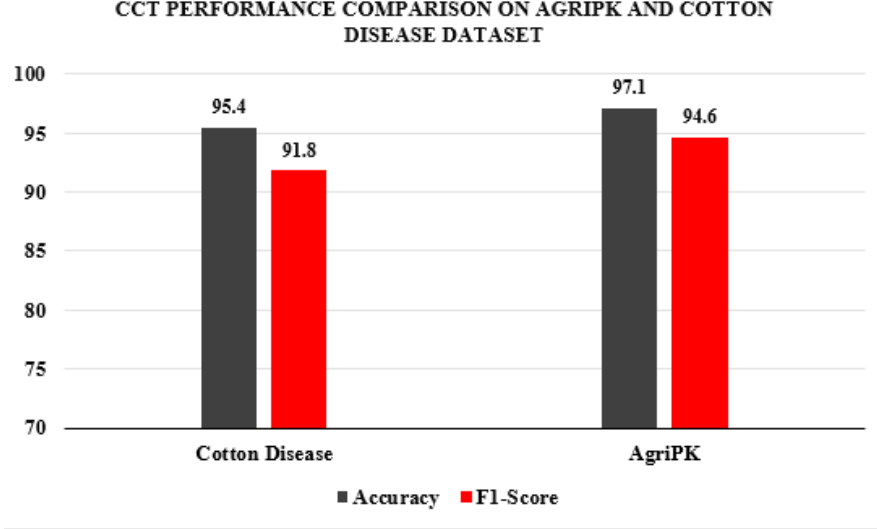
Figure 10. Accuracy and